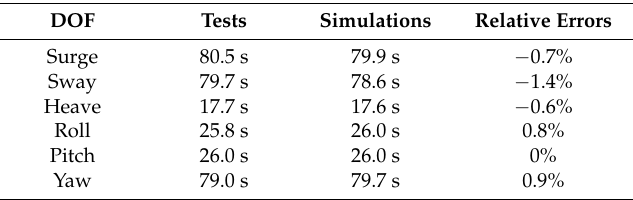
Table 5. Comparison of test and simulation free decay results.